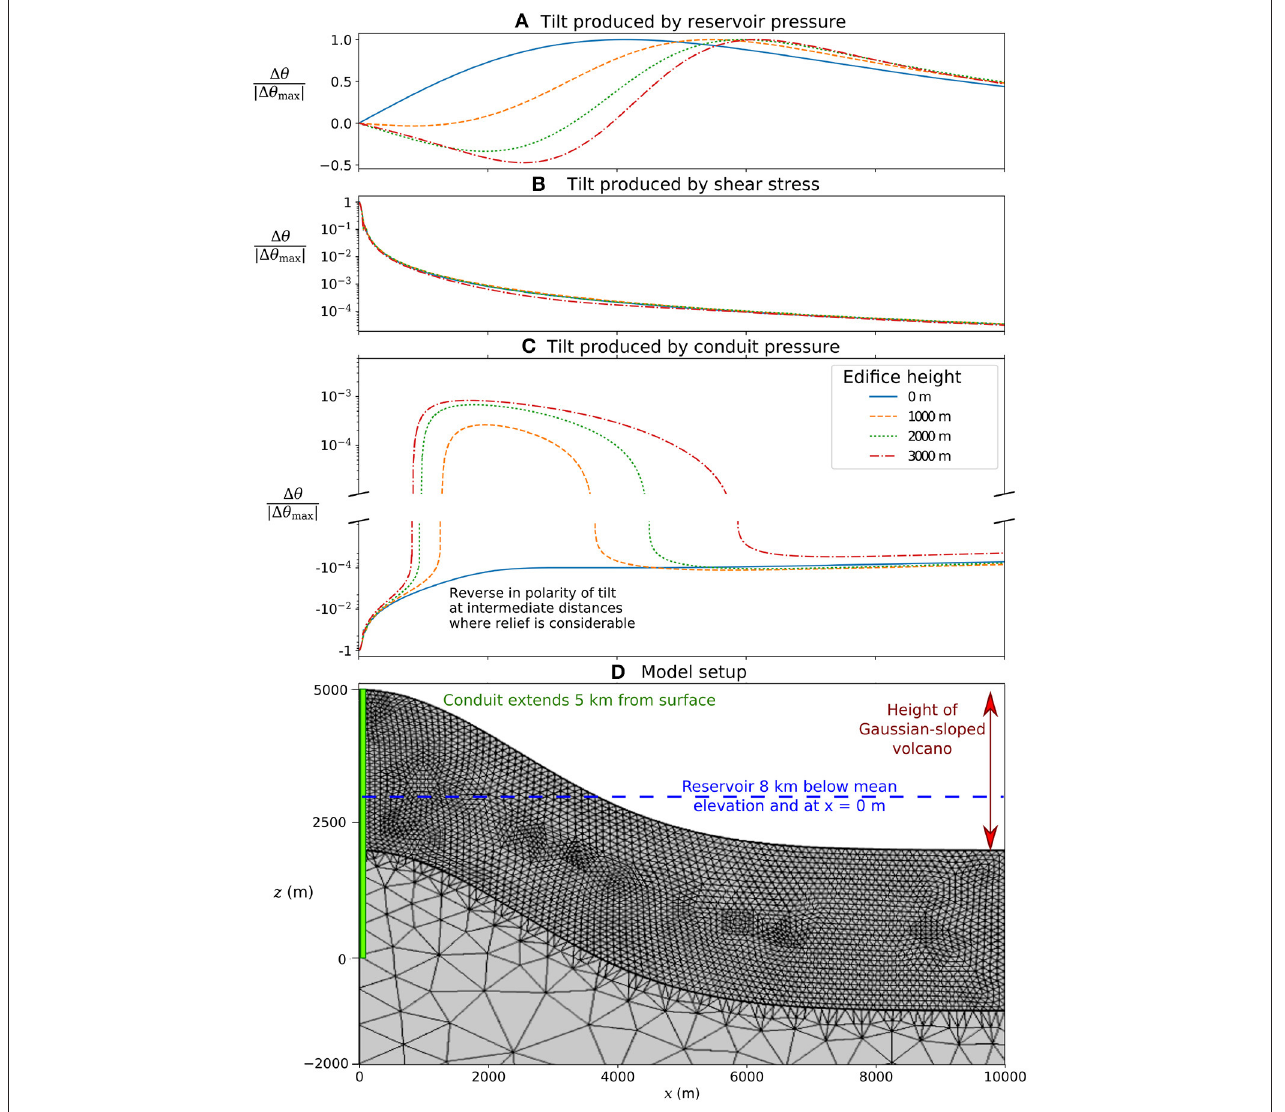
FIGURE 2 | Modeled tilt 1θ produced by (A) reservoir pressure, (B) shear stress, or (C) conduit pressure, each as a function of horizontal distance from the conduit x . The height of the Gaussian-sloped volcano is varied. (D) Model setup. A high resolution mesh is used to a depth of 3 km below the surface, to a horizontal distance of 10km, with a minimum element size of around 30